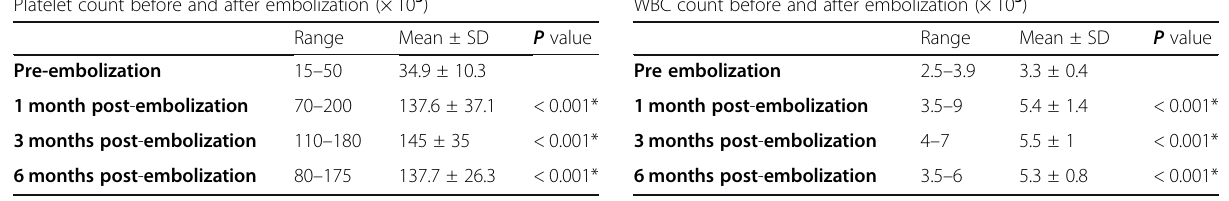
Table 3 Laboratory response based on platelet count Platelet count before and after embolization (× 10 3 )